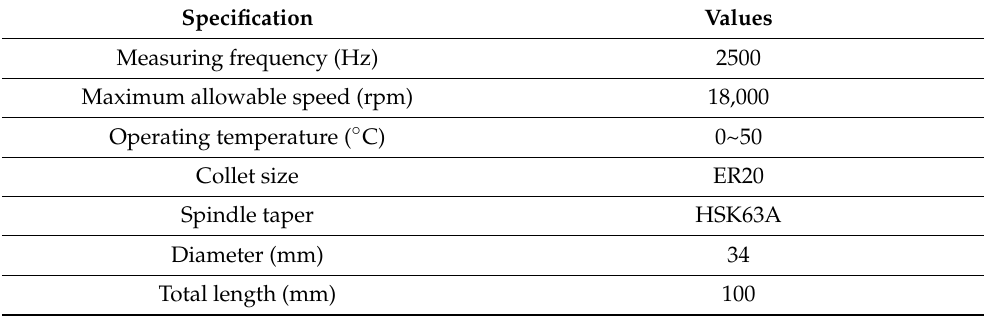
Table 3. Specification of the sensory tool holder.